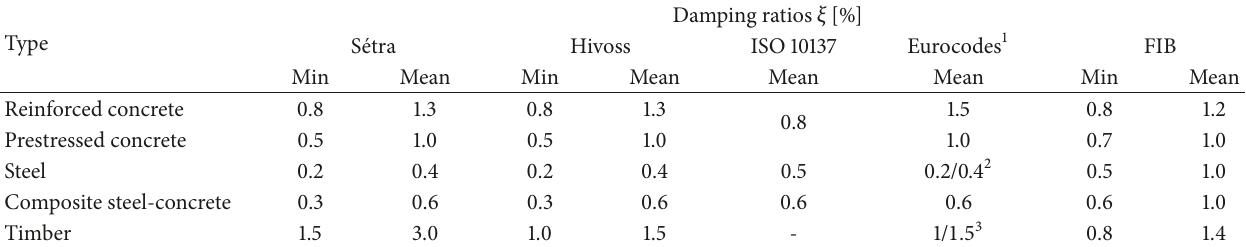
Table 1: Suggested damping ratios 𝜉[ % ] for different construction material, as given by different standards and guidelines. Type